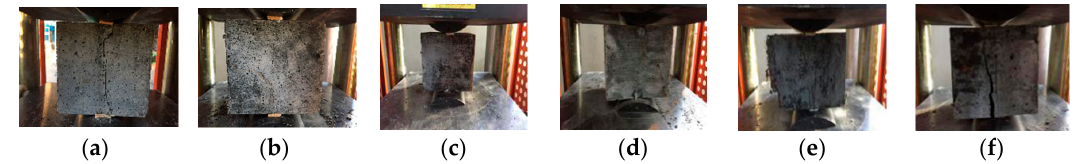
Figure 12. Splitting tensile strength failure mode of hybrid polypropylene-steel fiber RPC: ( a ) 0%, ( b ) 1%, ( c ) 1.25%, ( d ) 1.5%, ( e ) 1.75 and ( f ) 2%.